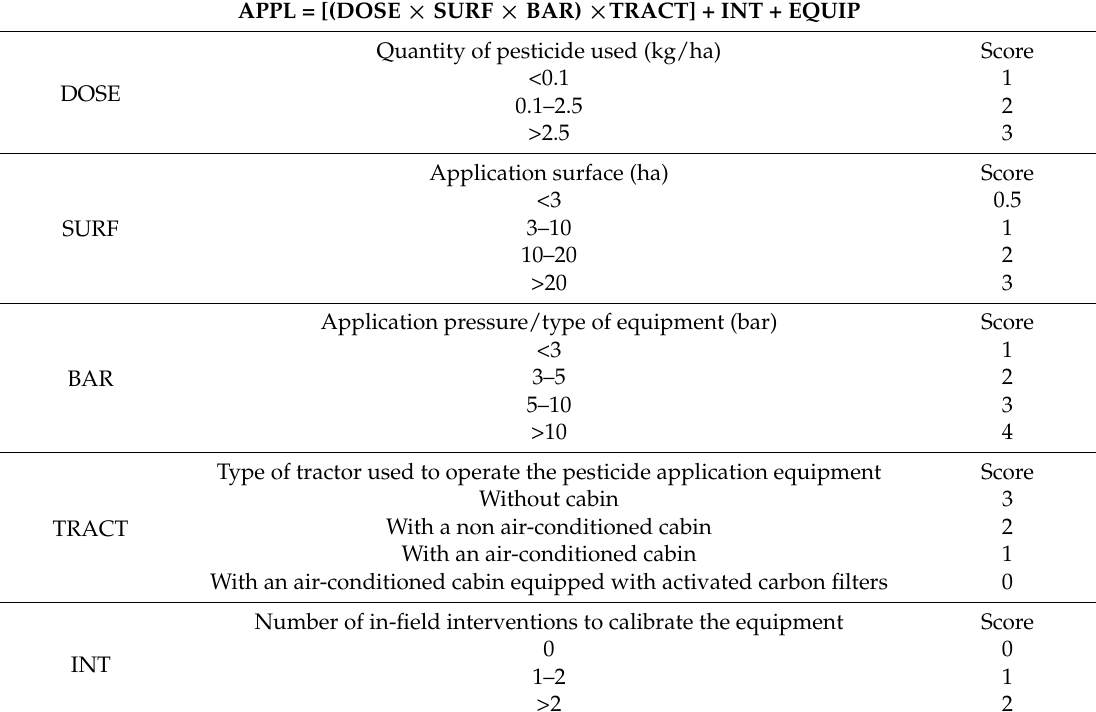
Table 4. Exposure factors during the application